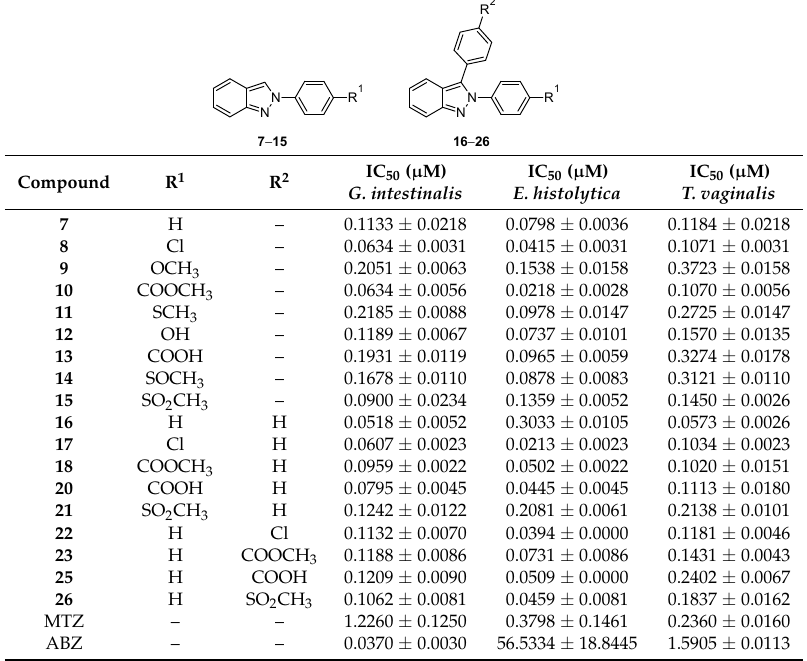
Table 2. Antimycotic effect for selected compounds.